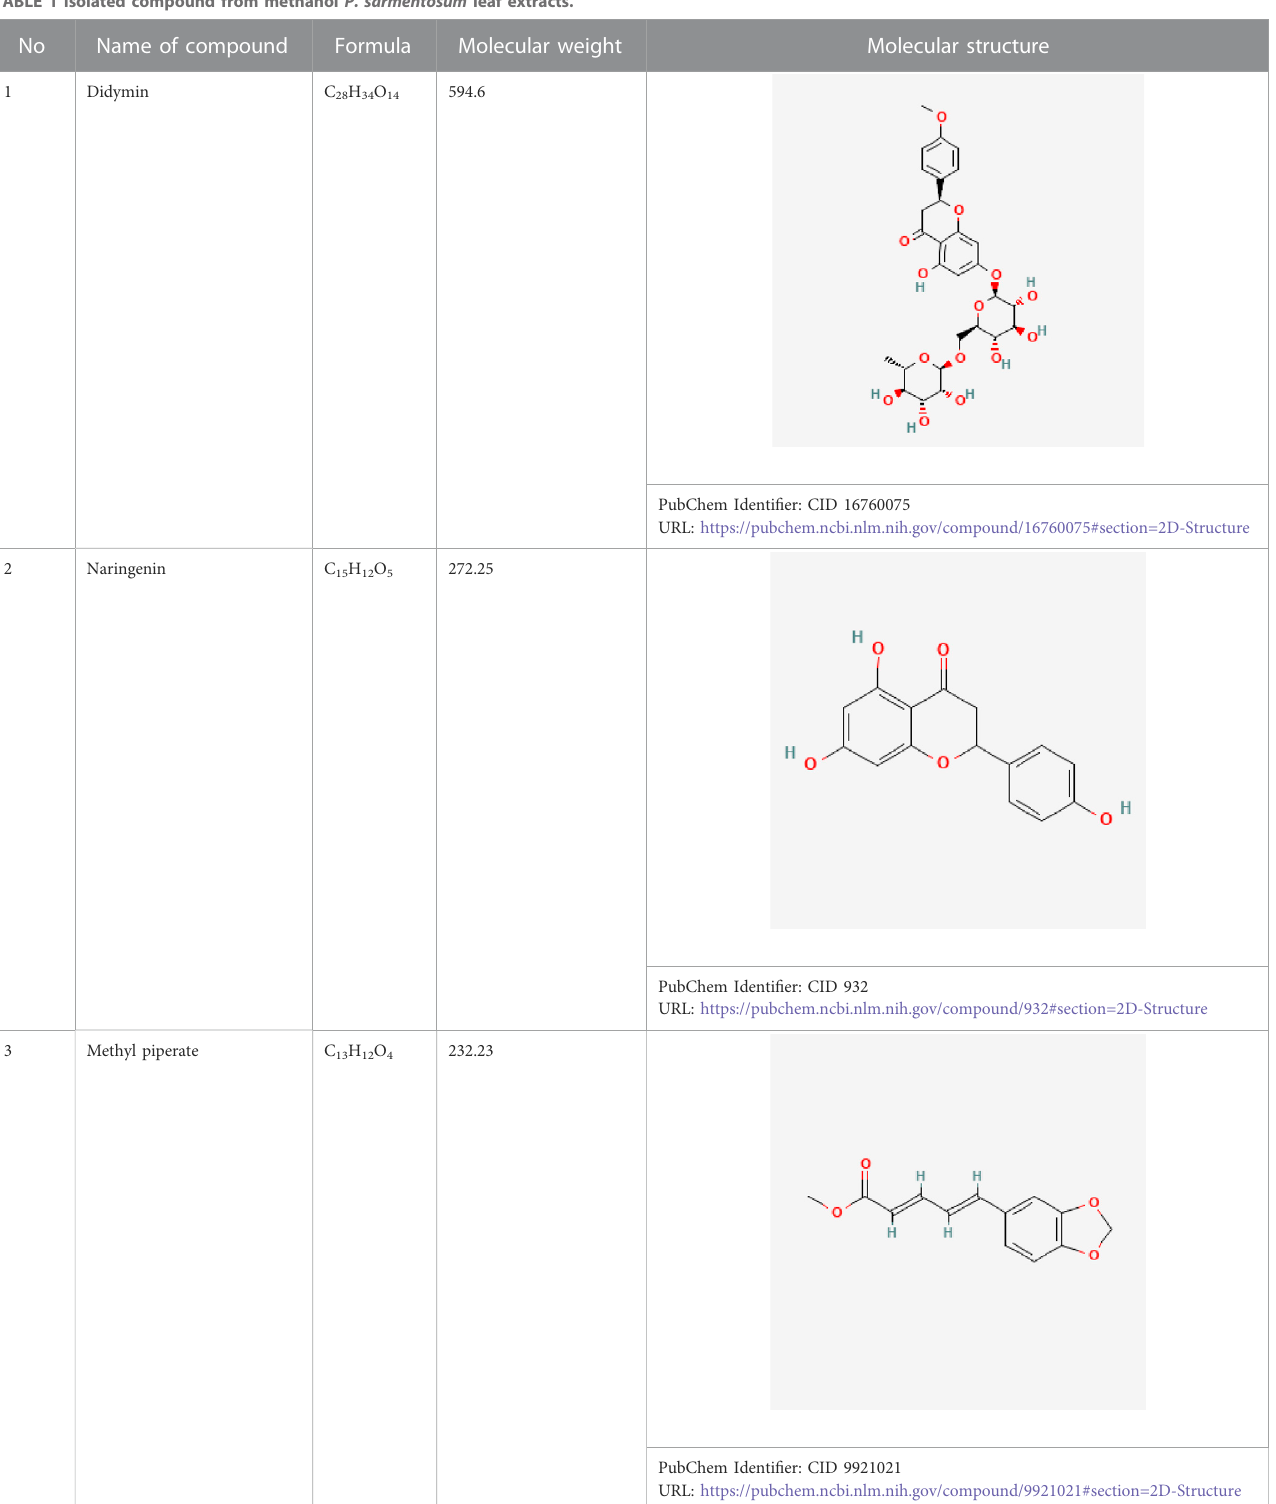
TABLE 1 Isolated compound from methanol P. sarmentosum leaf